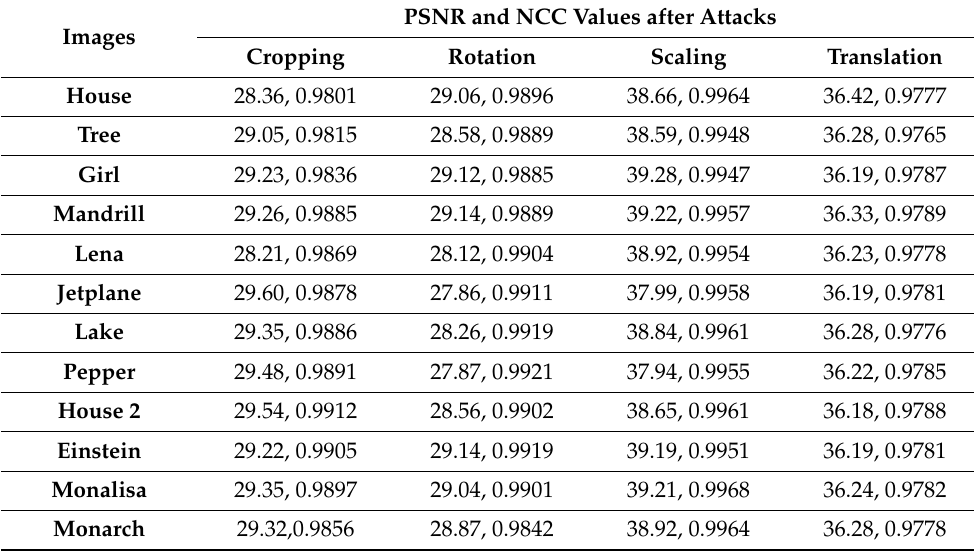
Table 4. PSNR and NCC values with geometric attacks on watermarked